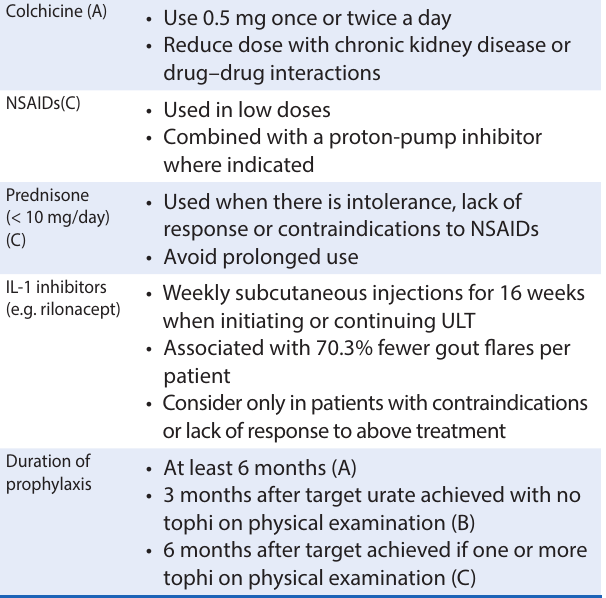
Table 3: Prophylactic therapy for acute attacks of gout (level of evidence in parentheses)